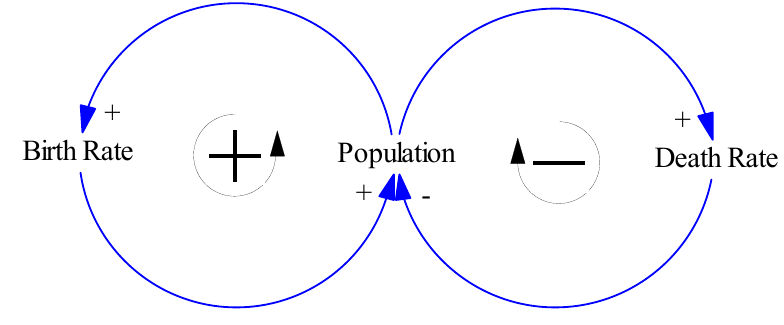
Figure 1. An example of a causal loop diagram.